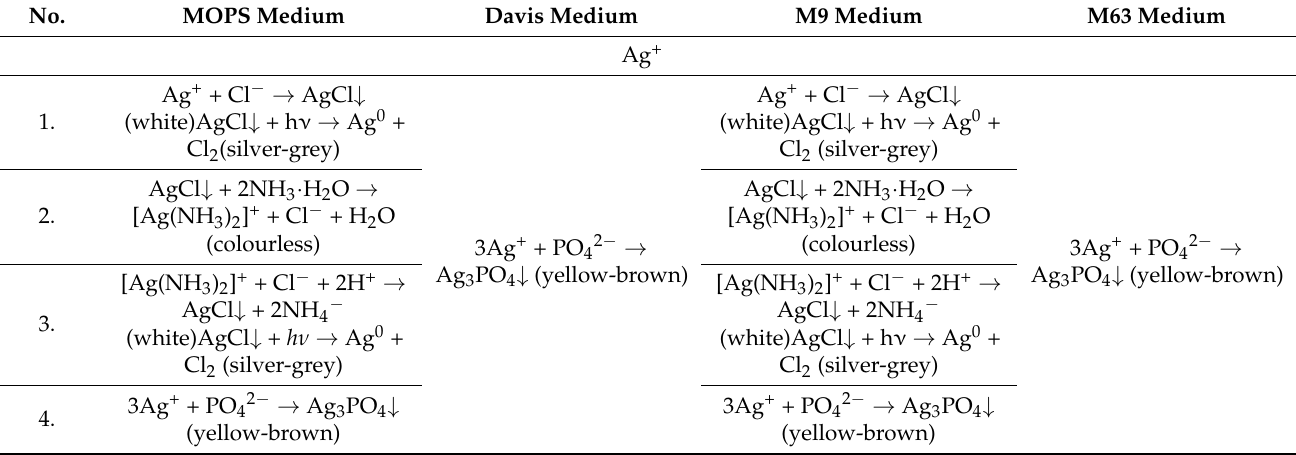
and metal ions was performed and the chemical reactions are listed in Table 3.